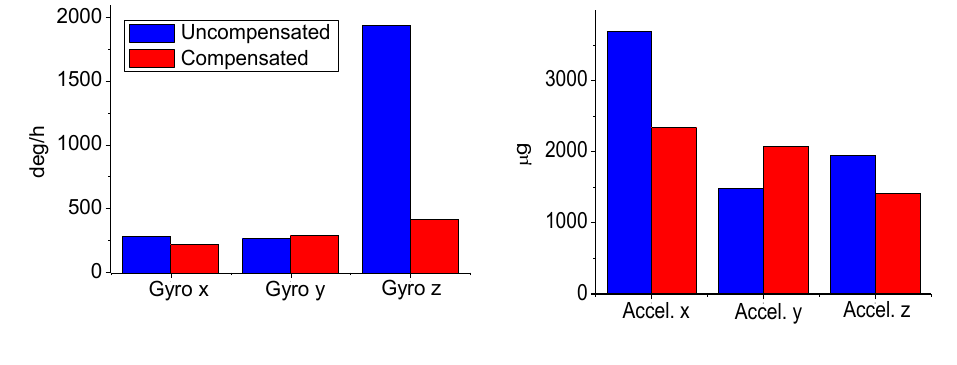
Figure 12. RMS values of MTi-G output errors with and without